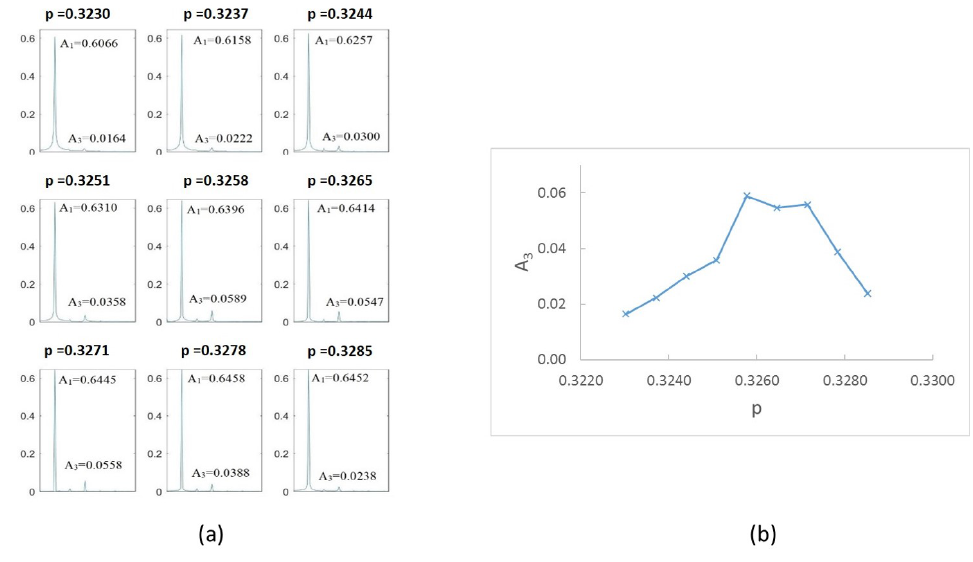
Ω c . ( b ) Amplituds A 3 versus rotation 3